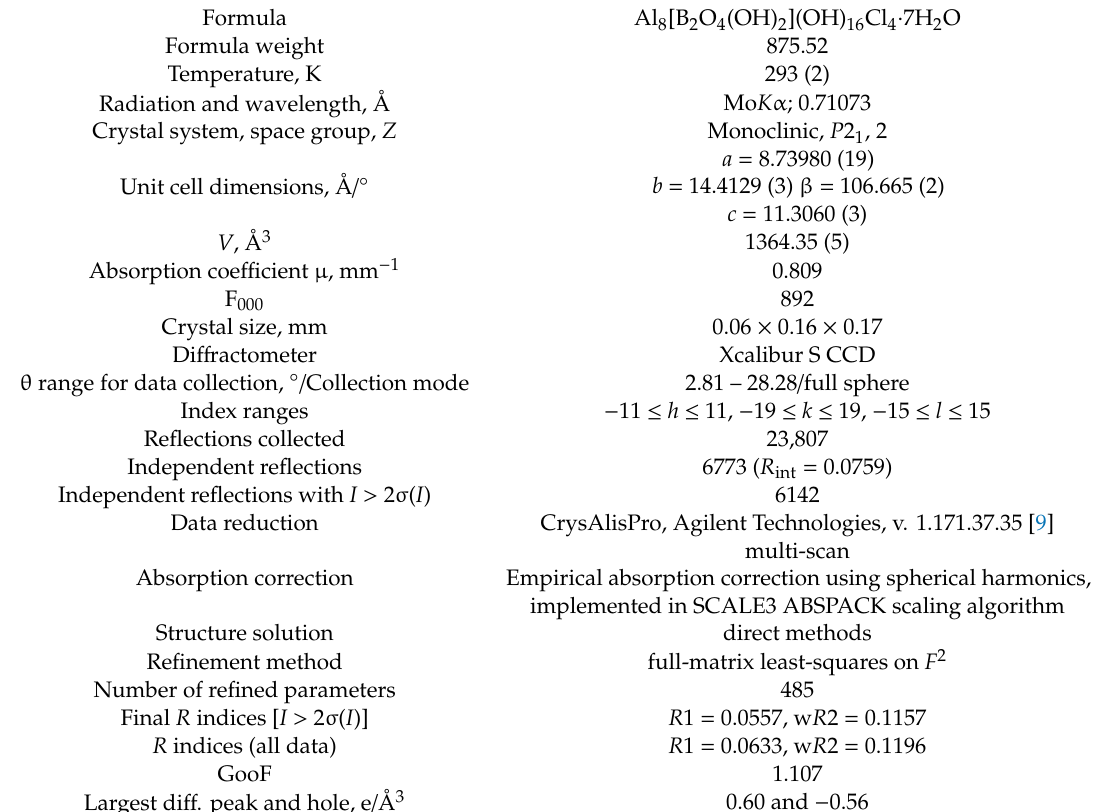
Table 2. Crystal data, data collection information and structure refinement details for krasnoshteinite.